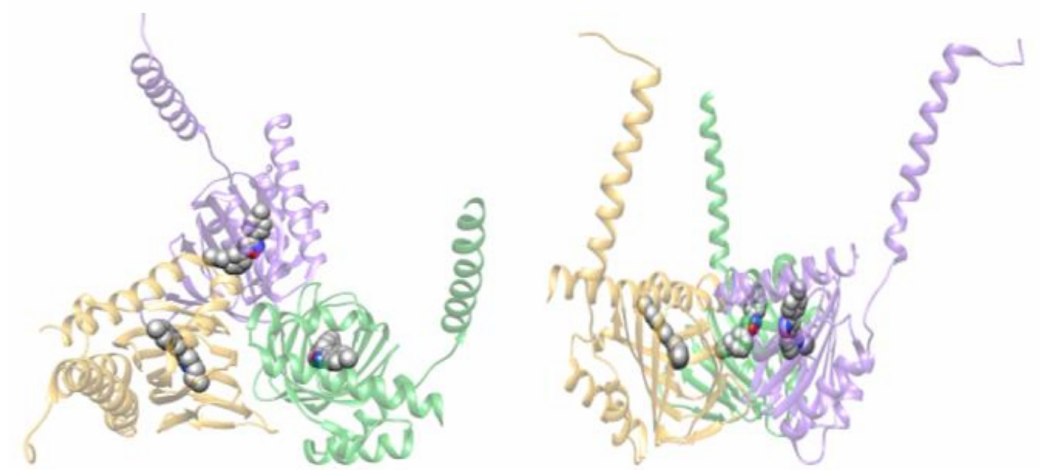
Figure 1. 3D structure of σ 1R in complex with PD144418 (PDB ID of co-ordinate file: 5HK1). The three identical protein monomers are shown as transparent ribbon and coloured green, yellow and purple, respectively. The ligand is shown as spheres and coloured by atom-type: C, white; N, blue; O, red. Left: top view. Right: side